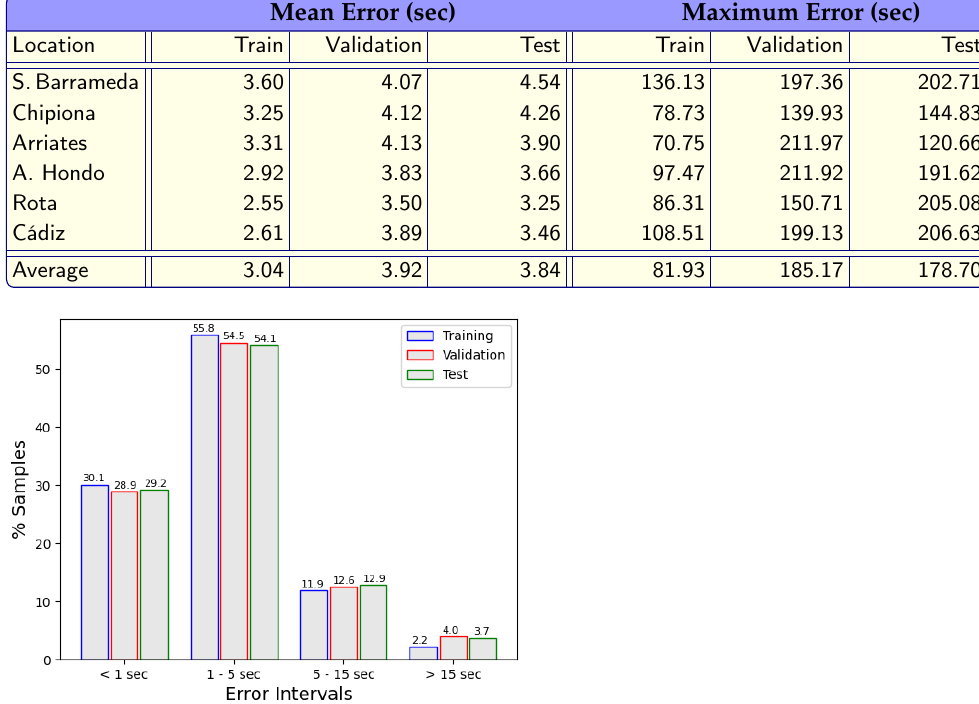
Figure 11. Percentage of predictions in certain error intervals in the arrival times problem with the ensemble model